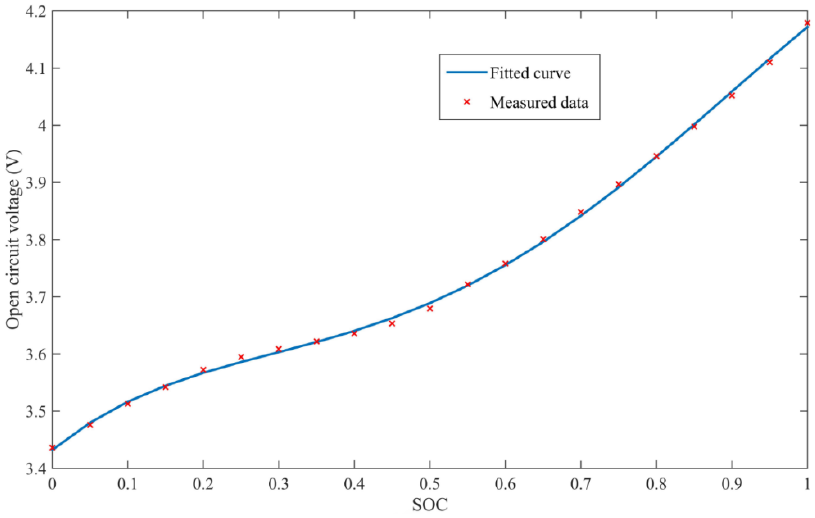
Figure 4. Comparison between the measured data and fitted curve.